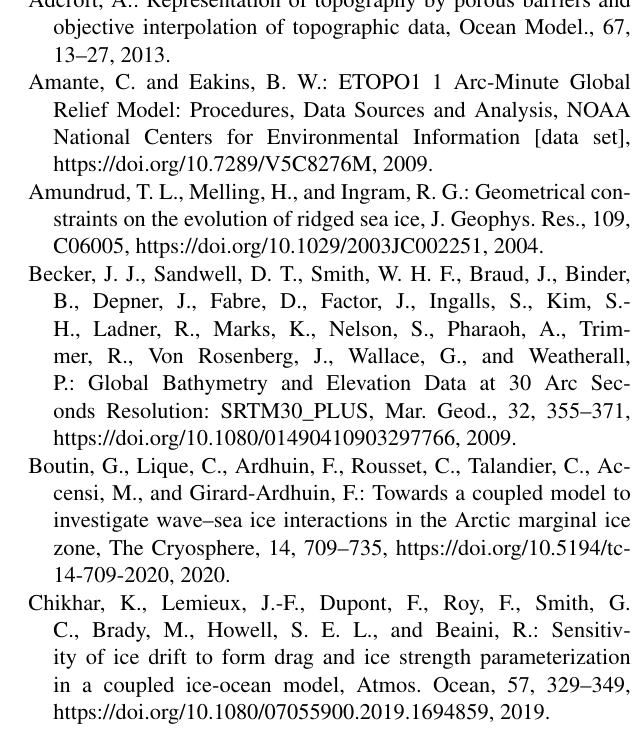
is needed in order to further refine the method and understand the local and non-local impacts of seabed–ice interactions on other aspects of sea ice